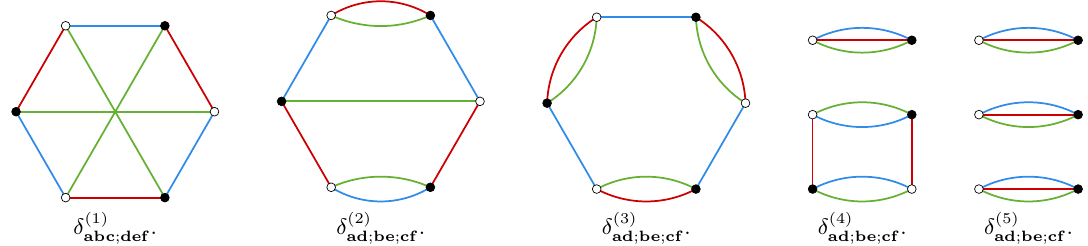
Figure 3. The five U( N ) 3 invariants. Each white vertex represents a field φ while each black vertex represents a field ¯ φ . Each edge corresponds to a contraction of indices and is assigned a color corresponding to the position of the indices in the tensor. The first invariant starting from the left is called the wheel